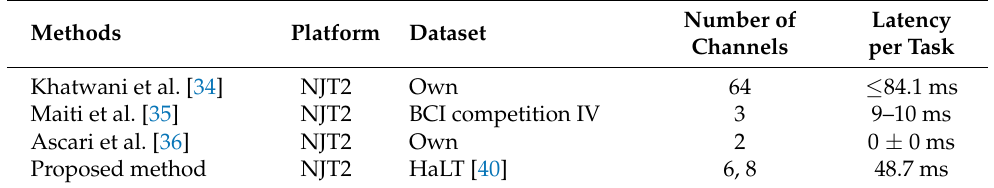
Table 12. Comparison with related works using neural network architectures on the NJT2